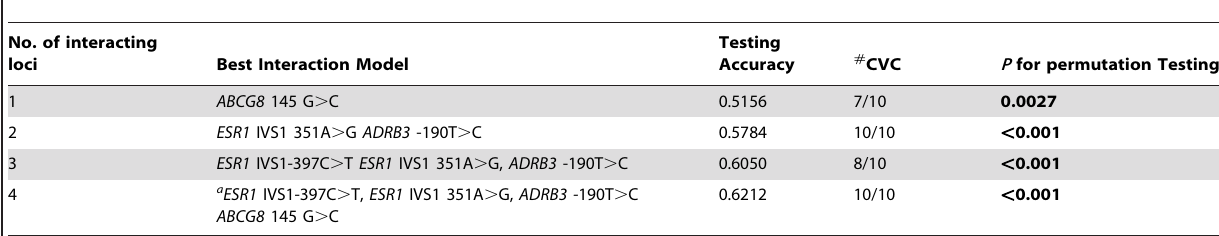
Table 6. Association of High-Order Interactions with GSD Risk by MDR Analysis.